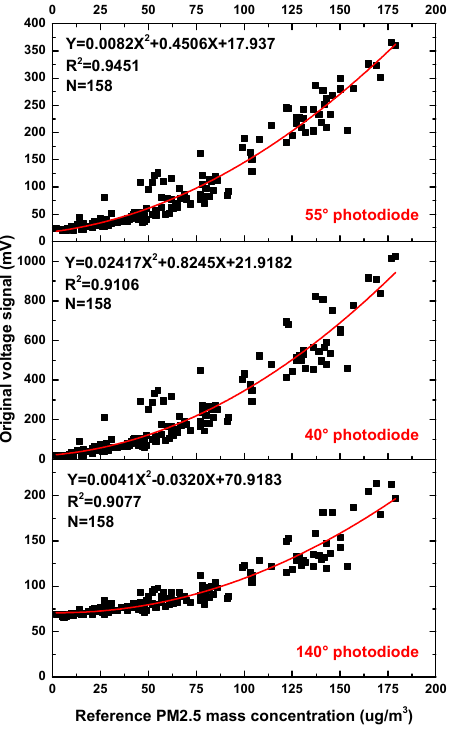
Figure 9. Output voltage of the three photodiodes in the particle sensor vs. 1-h average reference PM2.5 mass concentration.